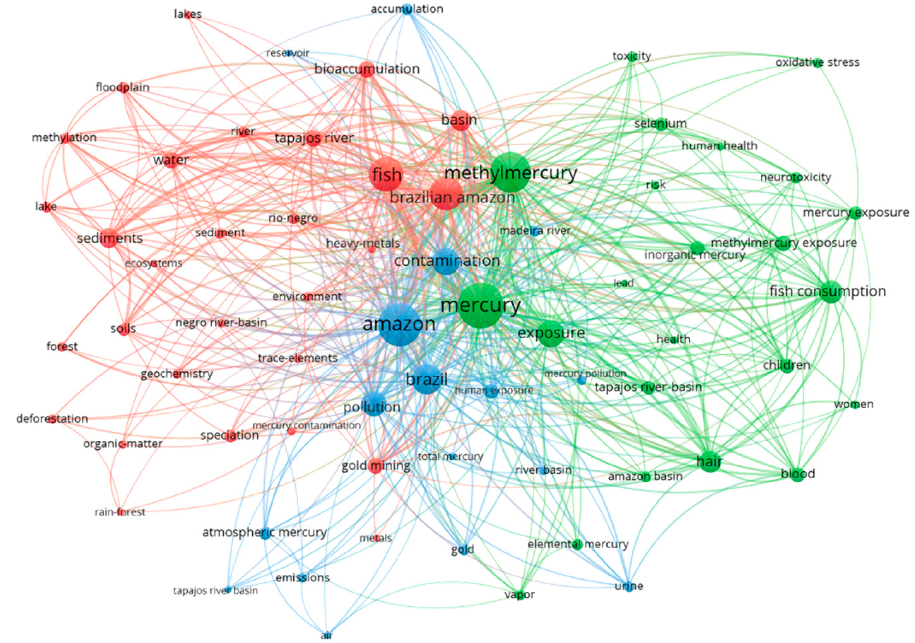
Figure 4. Networks of associations among the most used words in the titles and abstracts of publications on mercury in the Amazon between 1991 and 2017. The colors represent the clustering between them. Table 2. Main keywords ranked by frequency in papers dealing with mercury in the Amazon. Rank